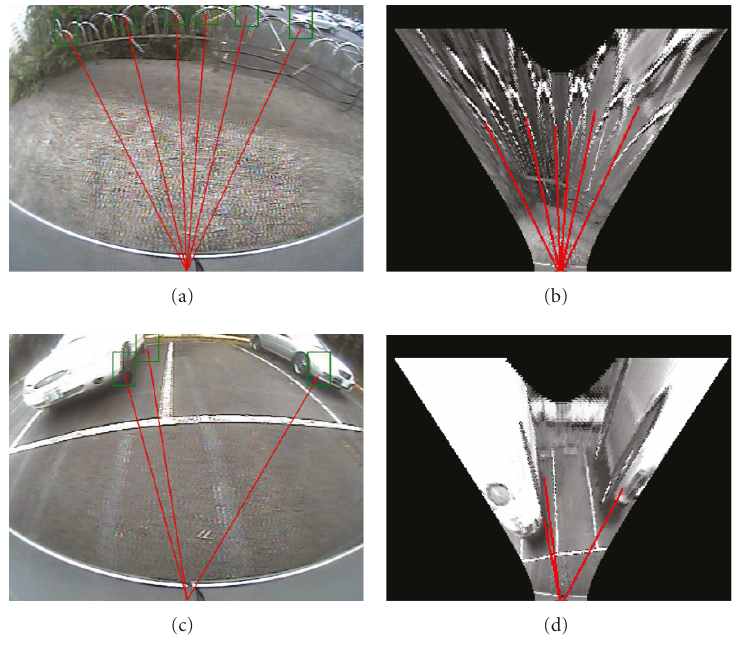
Figure 25: Results of obstacle warning in the lateral direction.